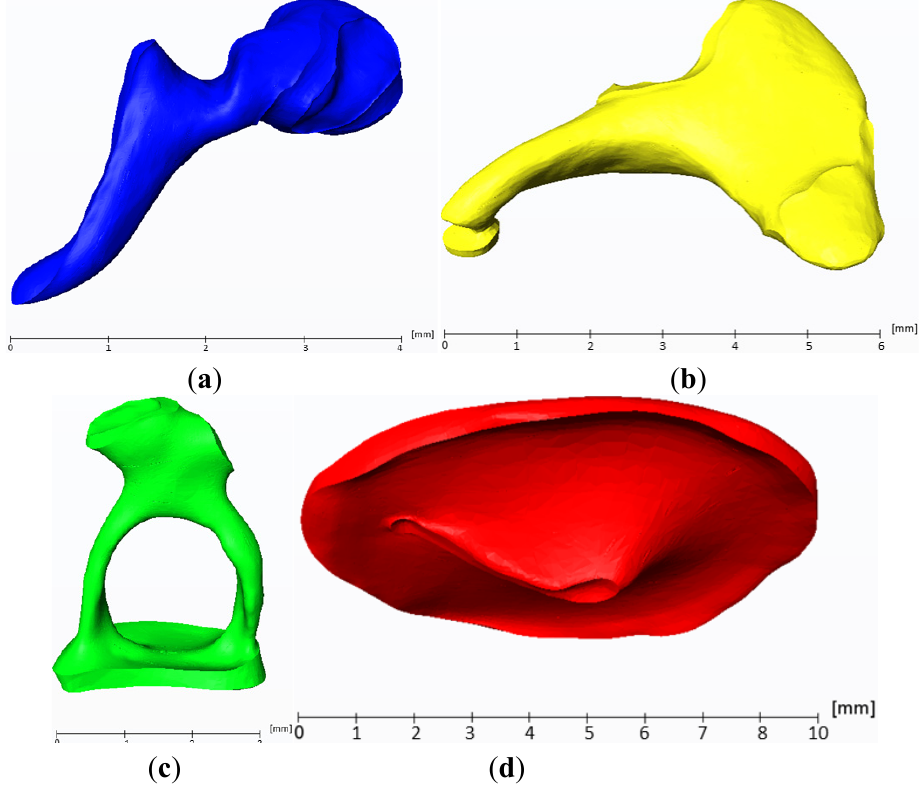
Figure 2. ( a ) 3D reconstruction of the malleus obtained from μ CT slice data. On the left, the curved shape of the manubrium of the malleus is seen. On the right, the emargination of the incudomalleolar joint in the malleus head is seen; ( b ) 3D reconstruction of the incus obtained from μ CT slice data; ( c ) 3D reconstruction of the stapes obtained from μ CT